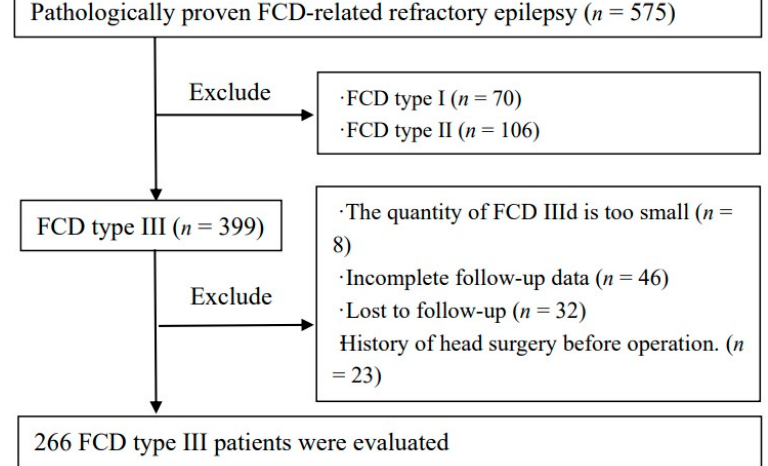
Figure 1. Inclusion and exclusion flowchart.